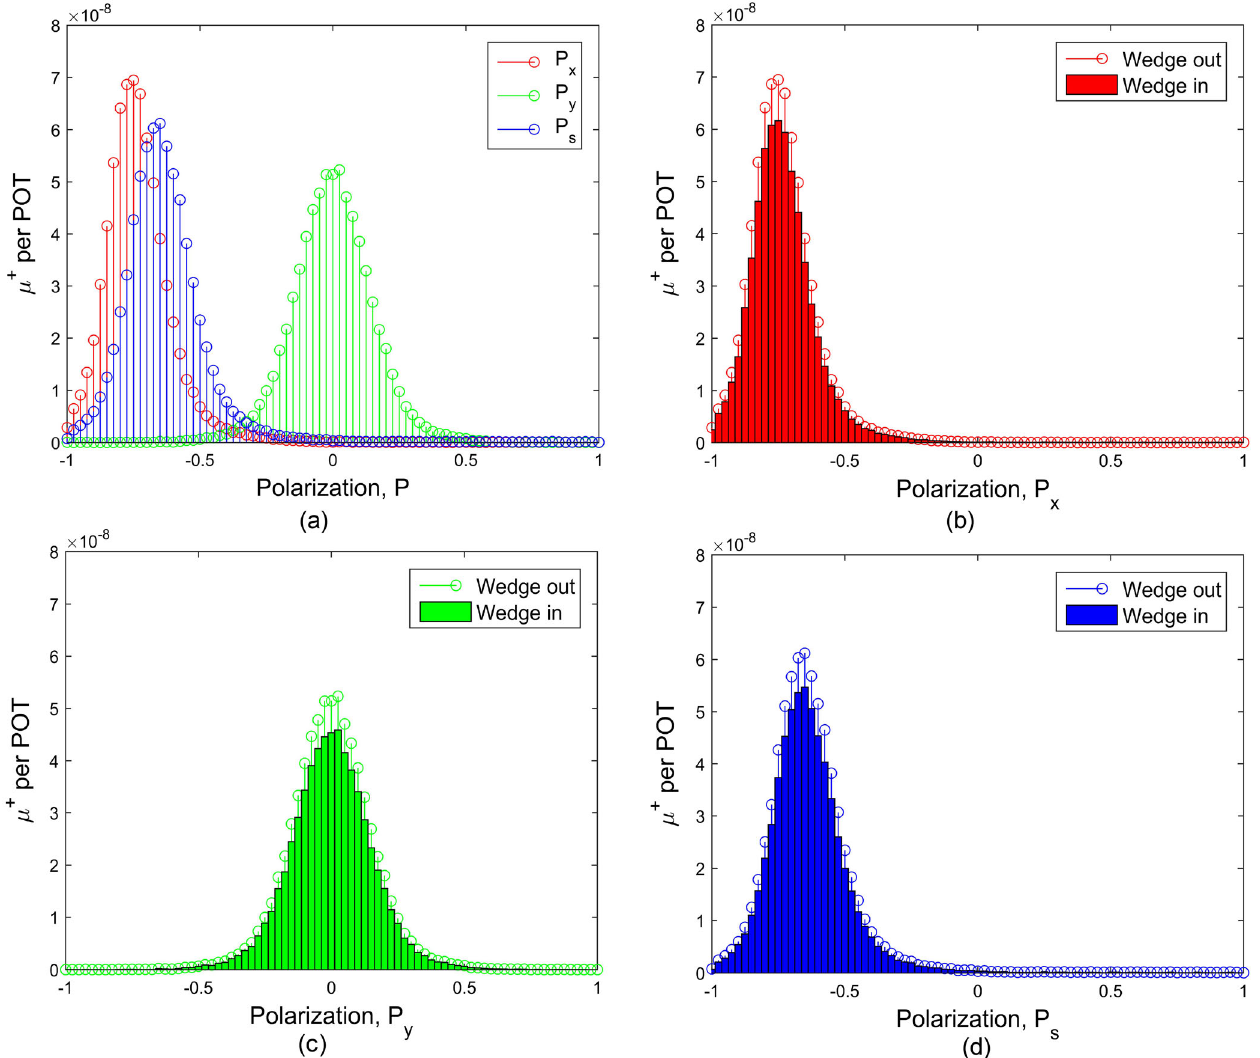
FIG. 13. Simulation results showing the distribution of the muon polarization at the end of M5. (a) Polarization without the wedge. (b) Polarization in the horizontal plane with and without wedge. (c) Polarization in the vertical plane with and without wedge. (d) Polarization in the longitudinal plane with and without wedge. In all cases the polarization remains unchanged when the absorber is inserted along the beam